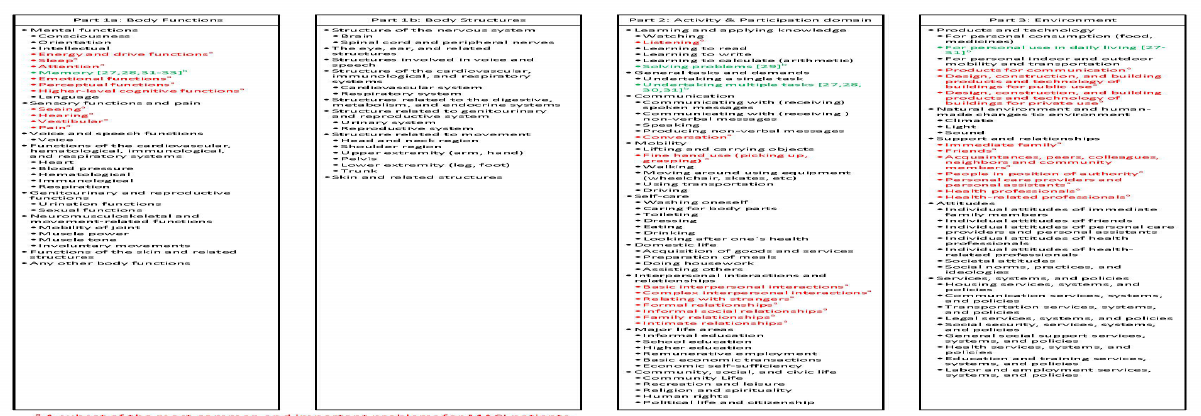
Figure 2. International Classification of Functioning, Disability and Health (ICF)